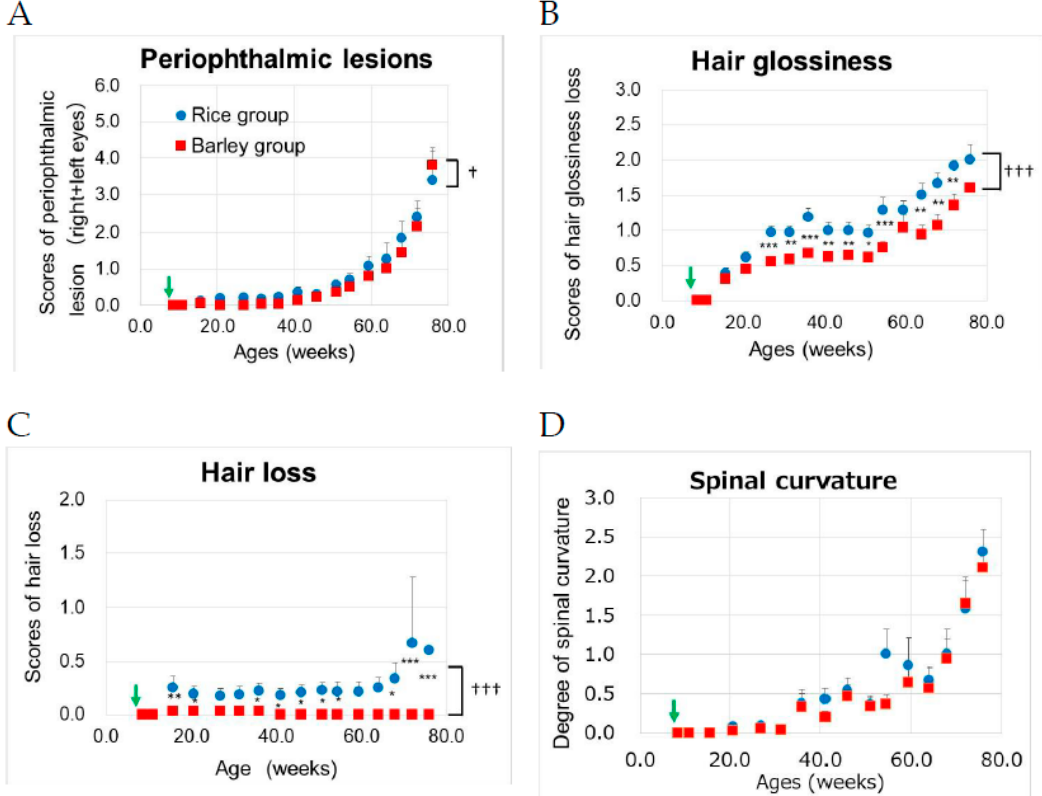
Figure 4. Changes in aging-related scores [26] in SAMP8 mice consuming rice or barley diets during the lifespan: ( A ) periophthalmic lesions; ( B ) hair glossiness; ( C ) hair loss; ( D ) spinal curvature. By two-way ANOVA, ††† p < 0.001, † p < 0.05; group, * p < 0.05, ** p < 0.01, *** p < 0.001; rice group